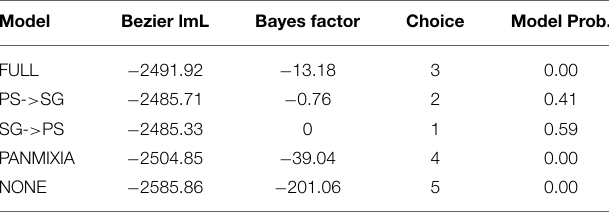
The limits of adult O. lymani/carinifera dispersal are unknown. TABLE 4 | Summary of the likelihoods of five competing migration